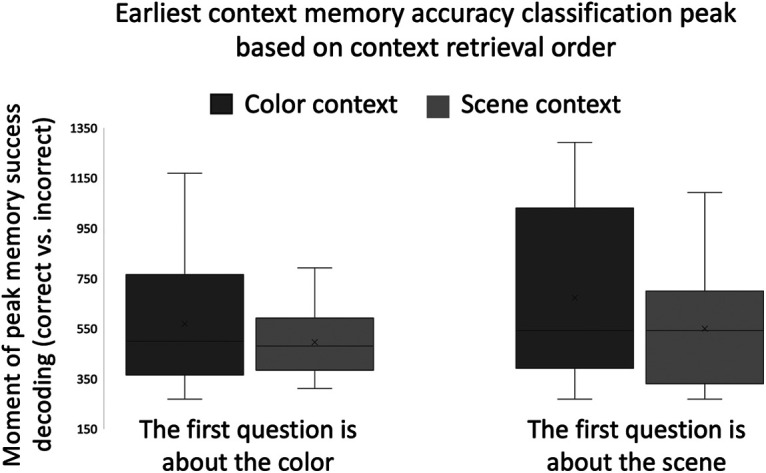
The earliest peaks of the context memory accuracy (correct vs incorrect) classification analyses for color and scene contexts, collapsed across encoding condition, compared between groups making either scene or color judgments first. As for the attention manipulation during encoding (Fig. 6), this pattern shows that one’s attentional state during retrieval impacts the temporal order of context memory retrieval.; × indicate the condition means while the horizontal lines indicate the medians.